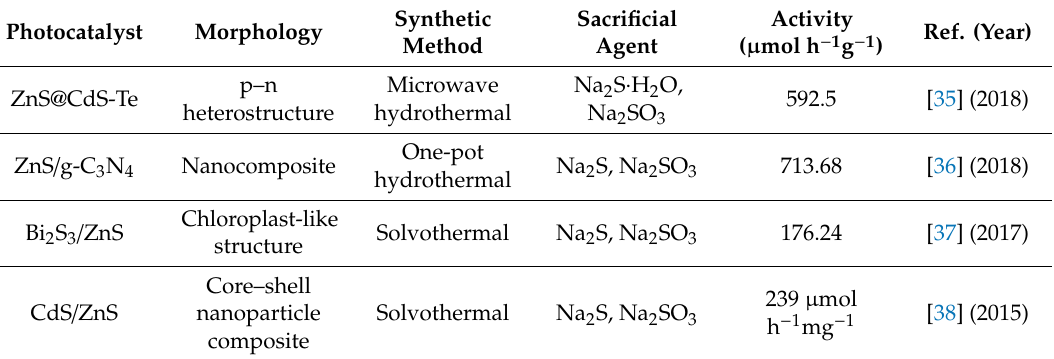
Table 4. Photocatalytic H 2 generation performances of ZnS-based